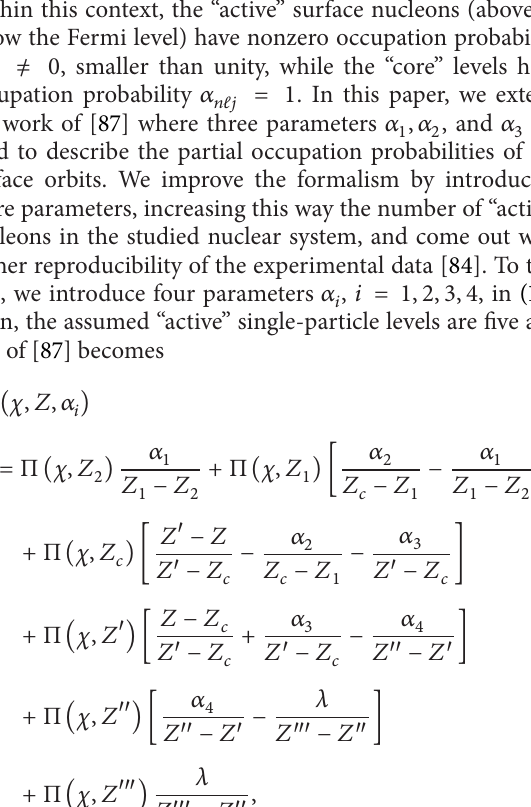
Nucleus Model-space 𝑏 Δ 𝑝 Δ 𝑛 𝑔 𝑝 12